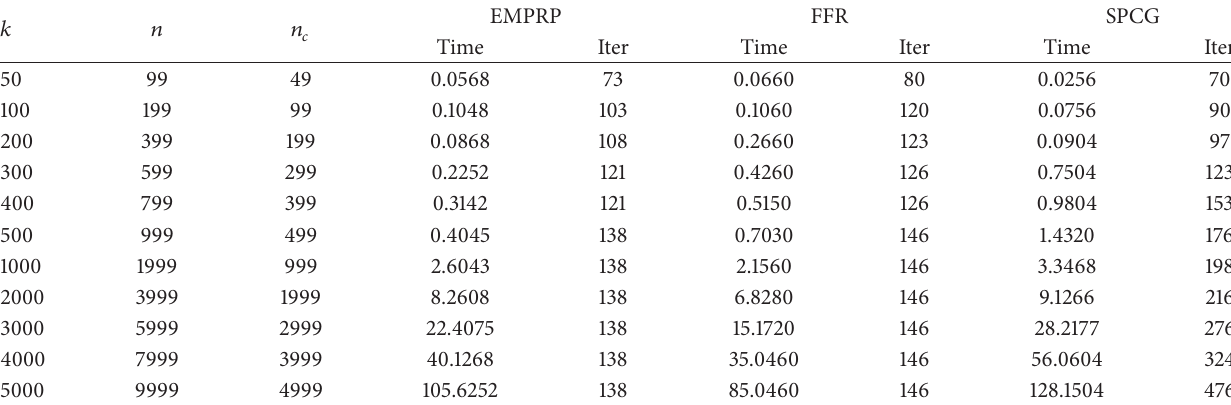
Table 2: Test results for Problem 6 with given initial